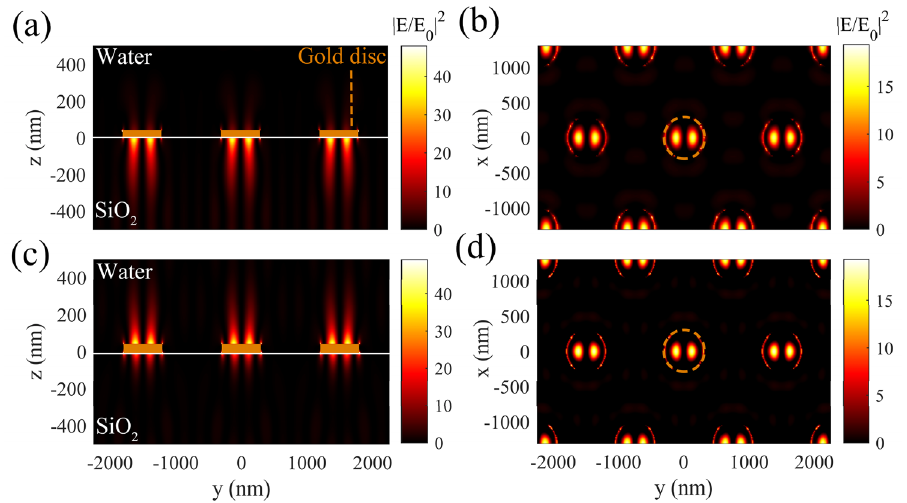
Figure 4. ( a ) the cross section, and ( b ) top views (at z = − 10 nm) of the normalized field intensity distribution corresponding to peak (ii) of the blue spectrum in Fig. 3b. ( c ) The cross section, and ( d ) the op views (at z = 10 nm) of the normalized field intensity distribution, corresponding to peak (iii) of the blue spectrum in Fig. 3b. The orange solid rectangles in parts ( a ) and ( c ), and the dashed circles in parts ( b ) and ( d ) represent the cross section and top views of the gold discs,